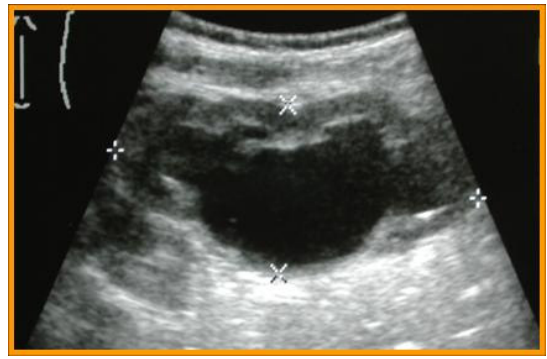
FIGURE 2. Grade 5 hydronephrosis on ultrasonography. Renal pelvis APD >1.5 cm and severe caliectasis with cortical atrophy (thickness <2 mm).